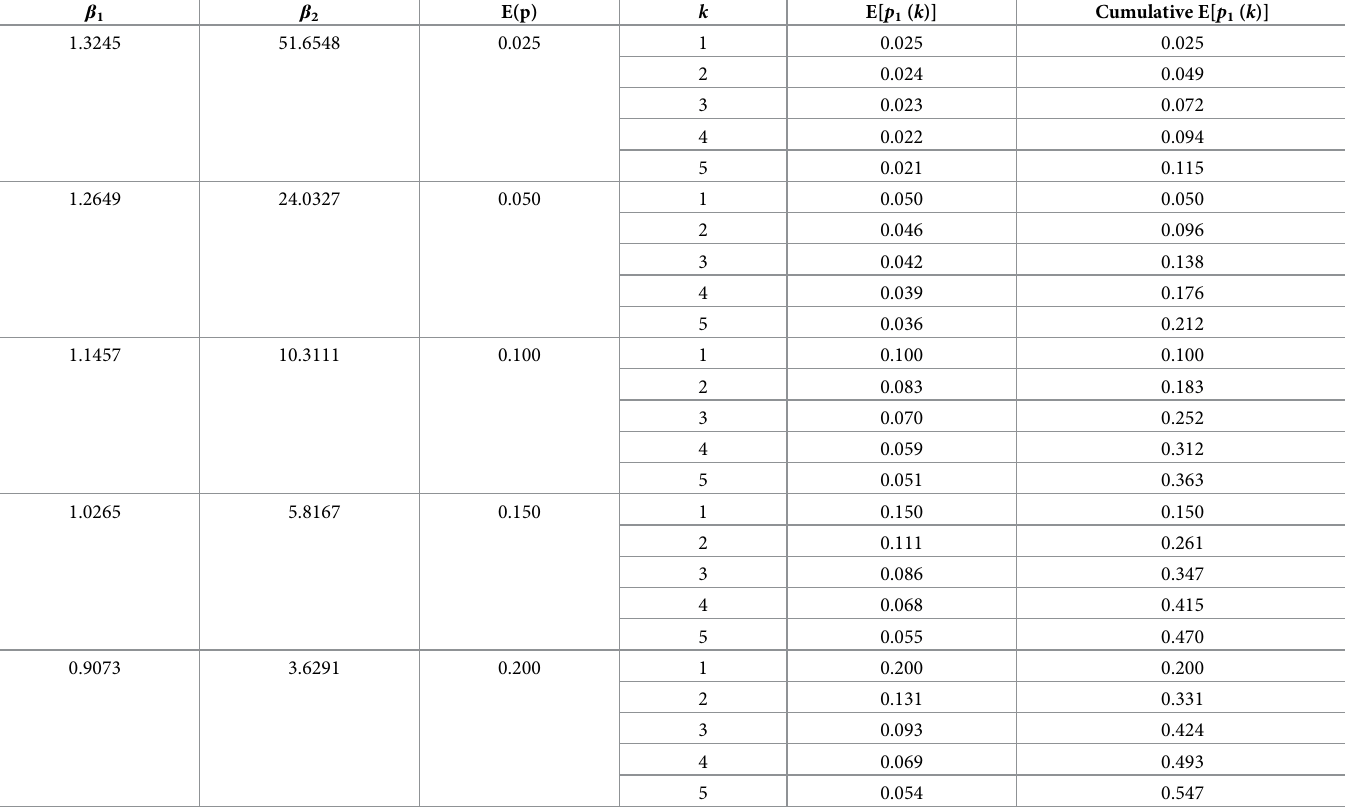
Table 1. Shape parameters β 1 and β 2 for the data-generating Beta distributions, expected encounter probabilities E(p), and expected proportions population mem- bers encountered for the first time on list k = 1, ... , 5, E[ p 1 ( k )]. β 1 β